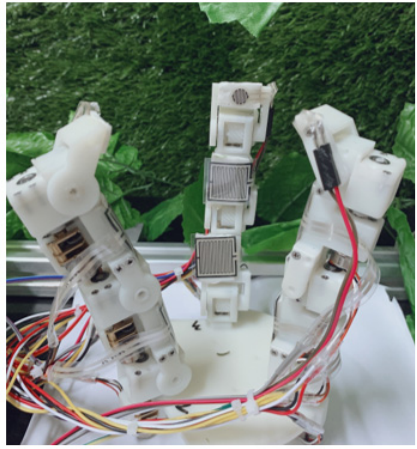
Figure 20. Physical view of tomato picking end-effector.